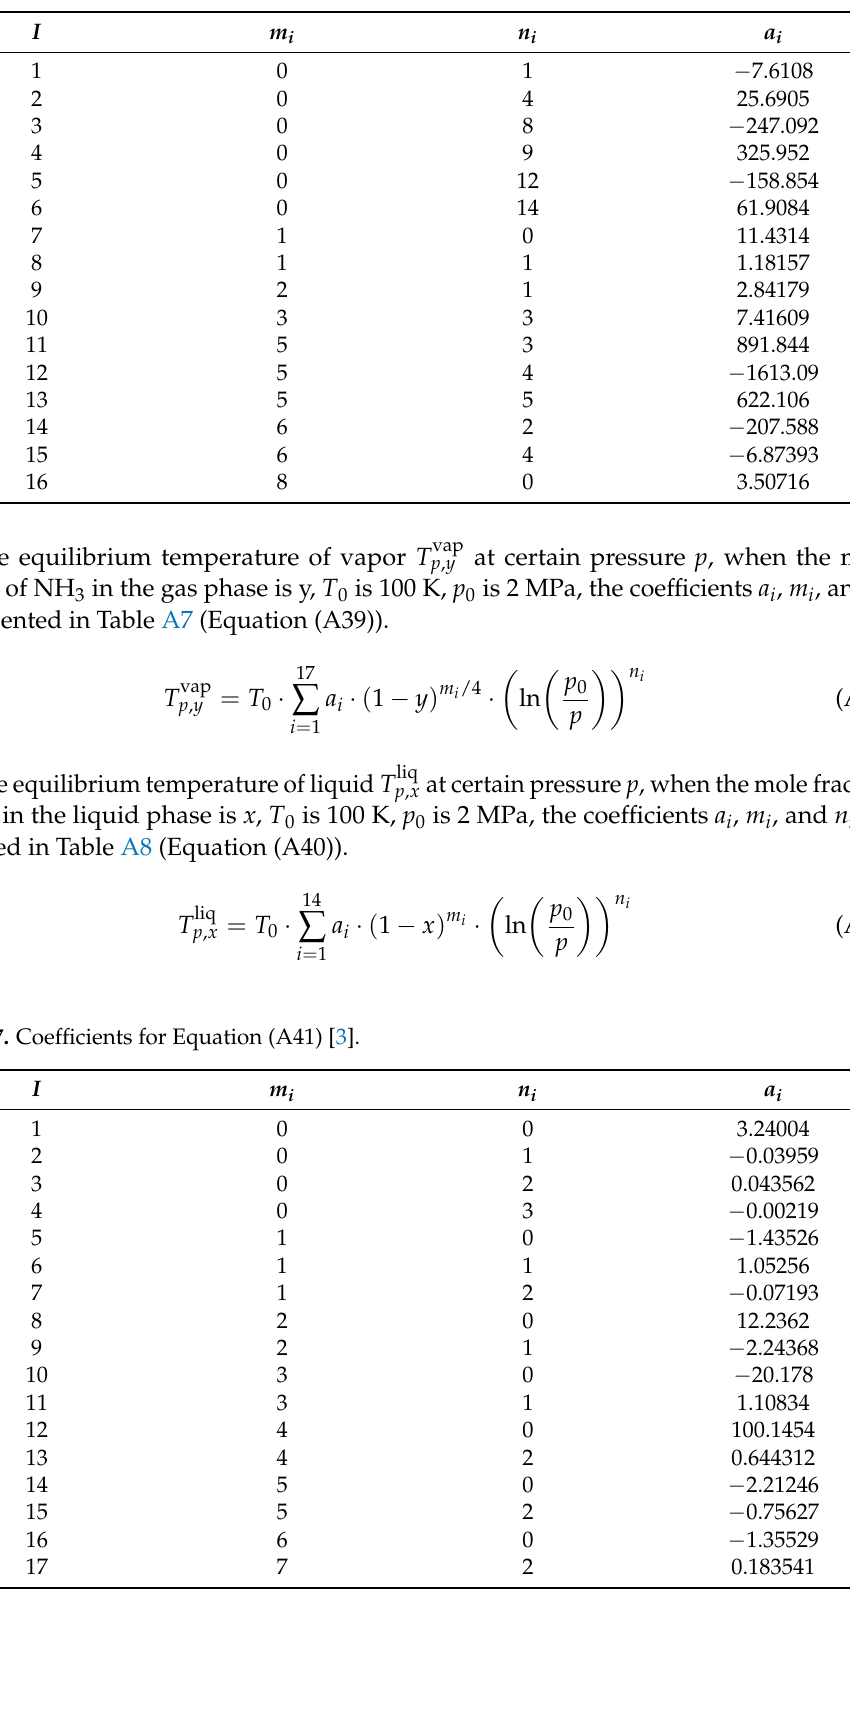
Table A6. Coefficients for Equation (A40) [3].